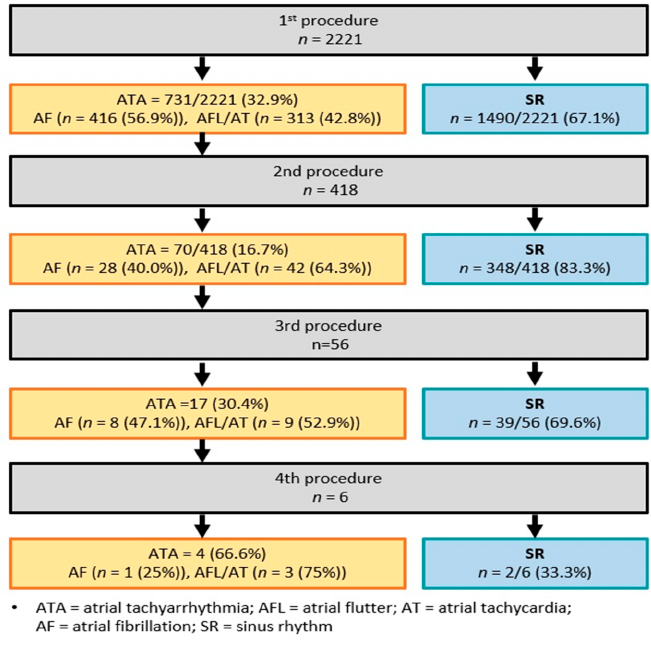
Figure 1. Flow chart of atrial fibrillation (AF) catheter ablation outcomes.